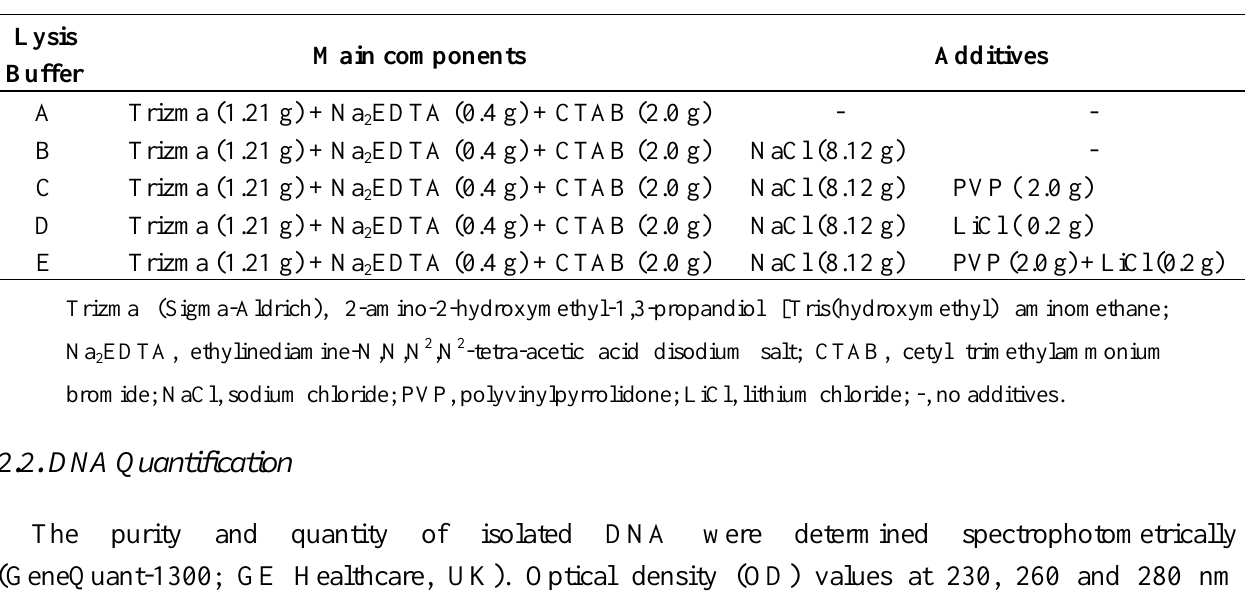
Table 1. Constituents of lysis buffers (100 mL, pH